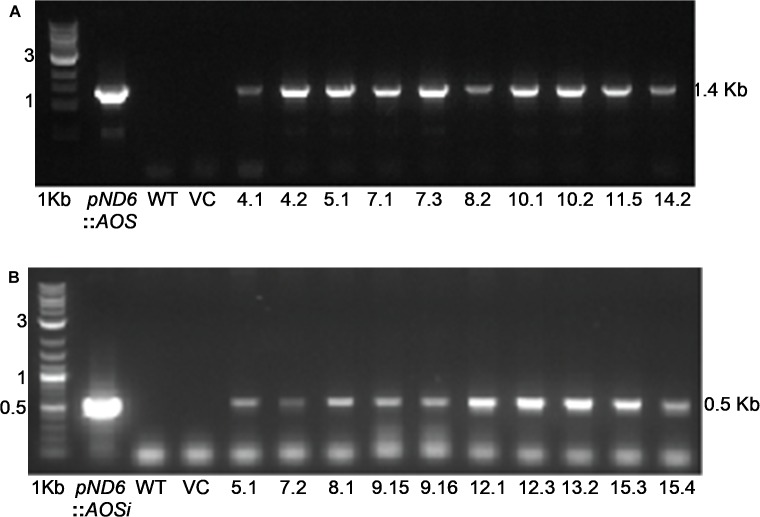
Genomic DNA PCR screening of (A) Overexpressing (AOSoe) and (B) downregulated (AOSi) transgenic guayule lines confirmed the presence of their corresponding transgenes. pND6::AOSoe and pND6::AOSi, transformation plasmid controls; WT, G7-11 wild-type control; VC, pND6 vector control.